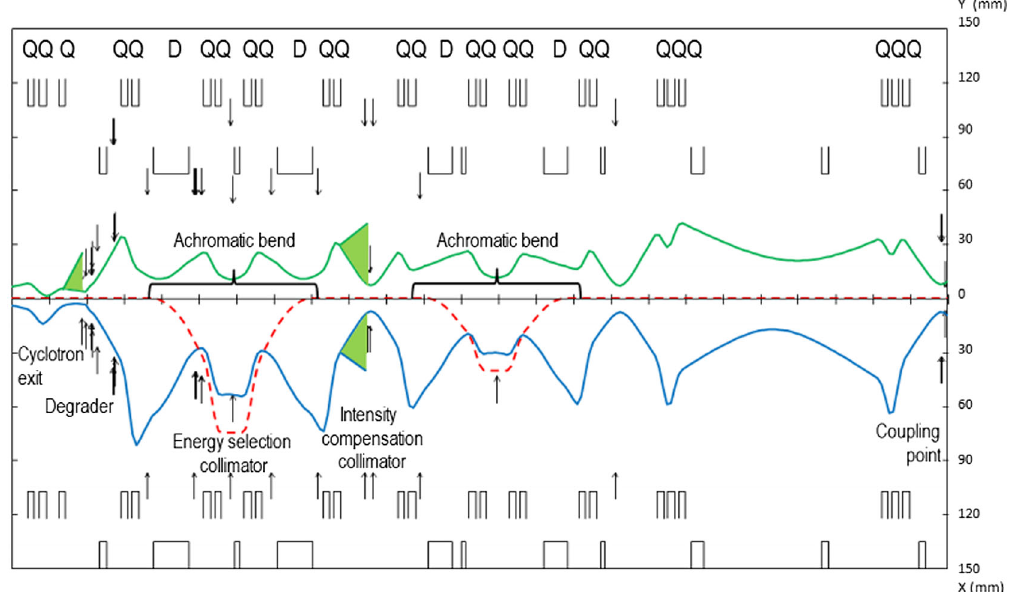
FIG. 2. Beam envelope of the TRANSPORT model from the cyclotron exit up to the coupling point of the Gantry 3 [22]. The blue and the green lines represent the beam size in the horizontal-(bending) plane and in the vertical plane, respectively. The trajectory of a particle with 1% momentum offset is marked by the red dashed line. The light-green areas indicate where the intensity compensation is